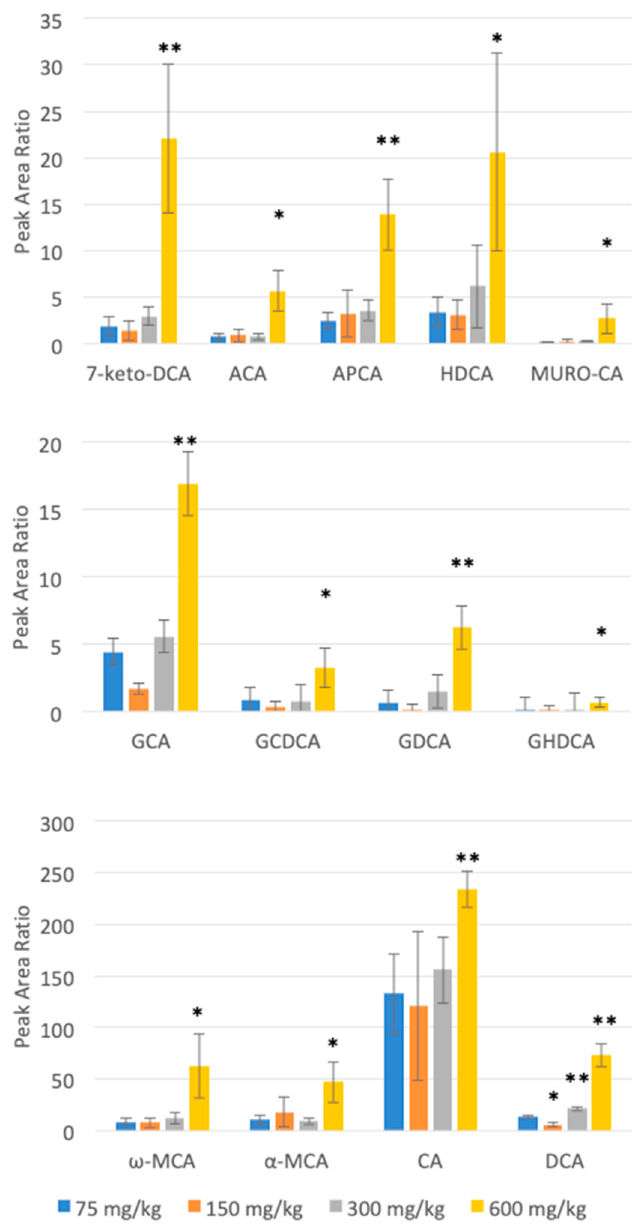
Figure 3. Peak area ratios for bile acids having significant changes between 75 mg / kg and 600 mg / kg APAP dosing, as measured in rat plasma after 24 h. * p -value < 0.05, ** p -value < 0.01.